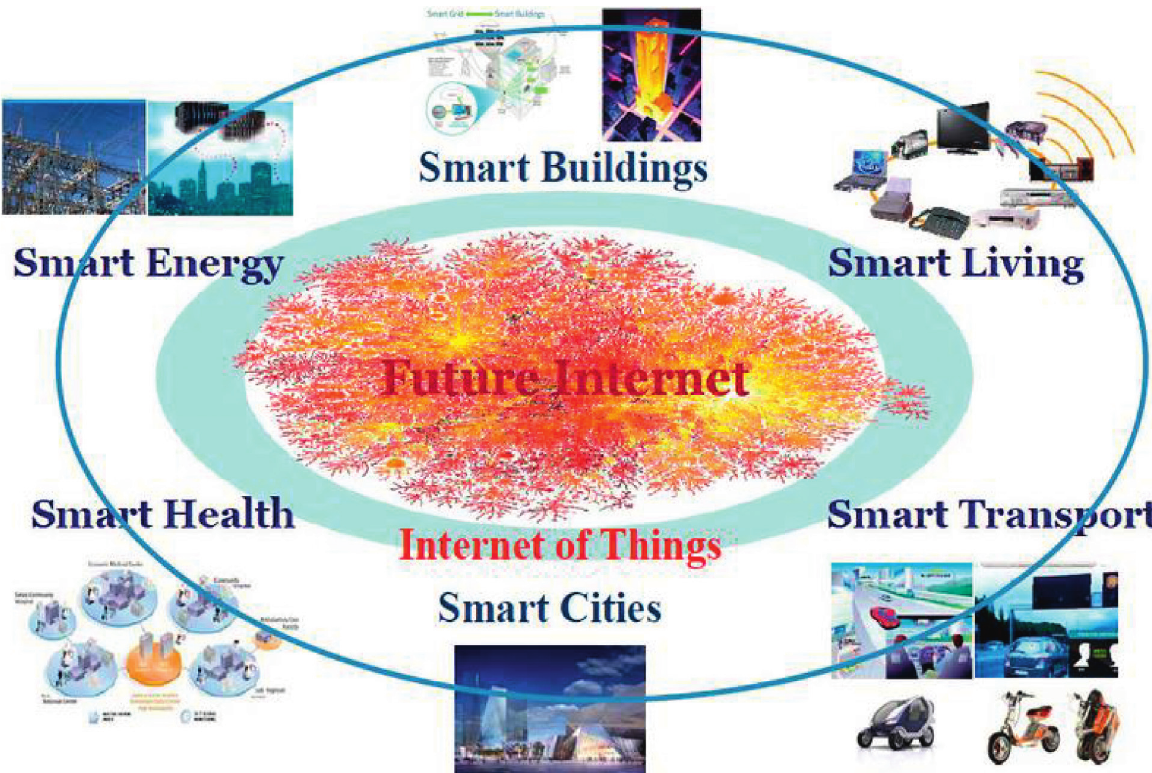
Figure 1: Future Internet and smart